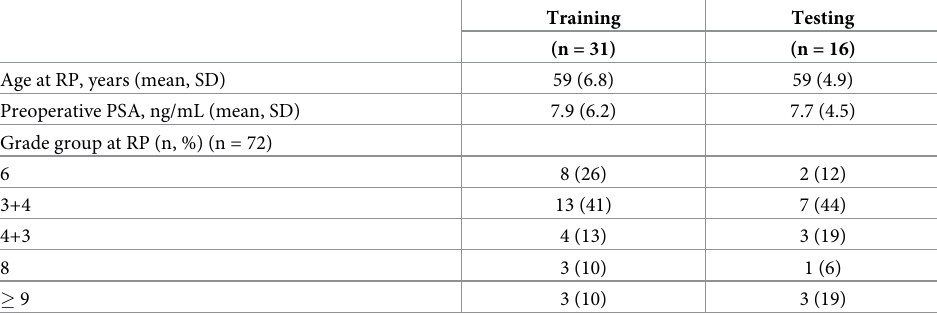
Table 1. Patient